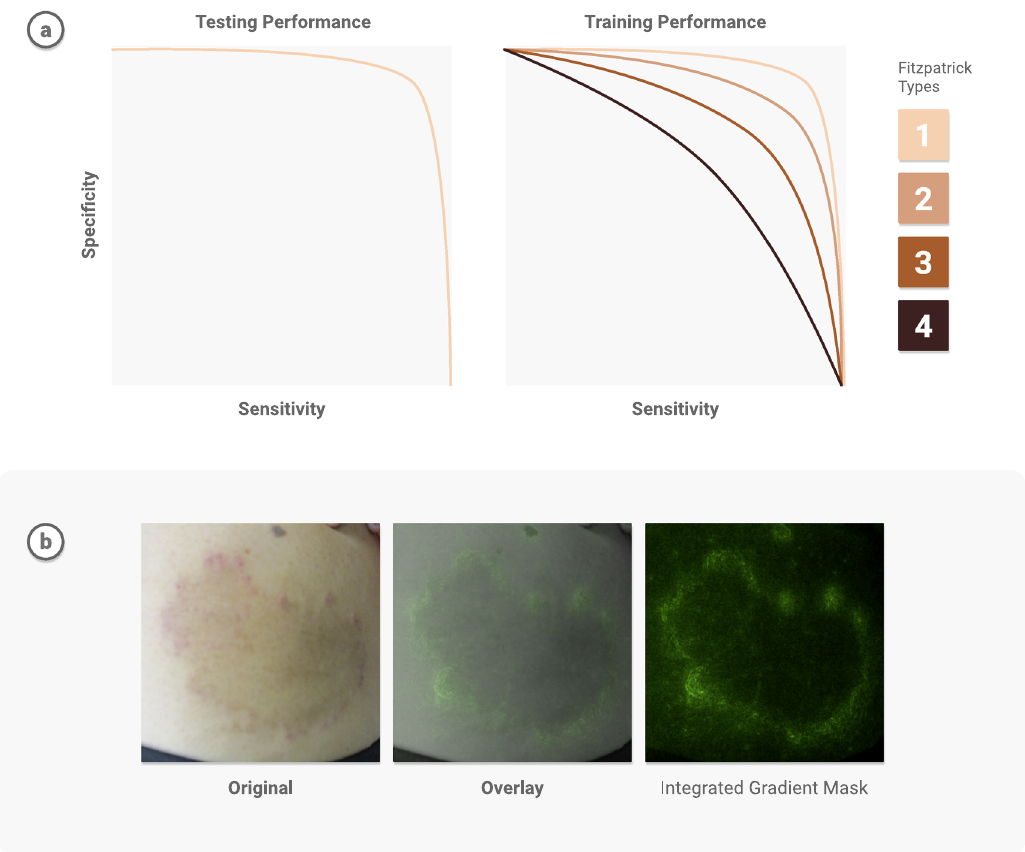
Fig. 4 Bias in deployment. a Example graphic of biased training data in dermatology. AIs trained primarily on lighter skin tones may not generalize as well when tested on darker skin 157 . Models require diverse training datasets for maximal generalizability (e.g. 95 ). b Gradient Masks project the model ’ s attention onto the original input image, allowing practitioners to visually con fi rm regions that most in fl uence predictions. Panel was reproduced from ref. 95 with